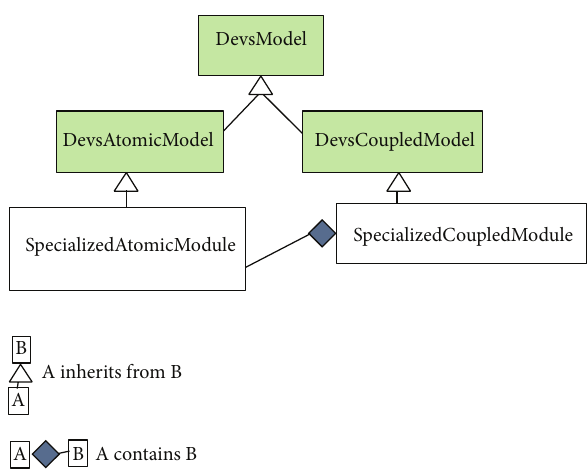
Figure 4: Class diagram of the package for DEVS support in DEUS we recently introduced.